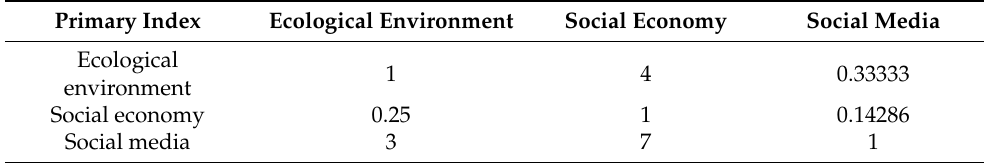
Table 6. Primary index judgment matrix.